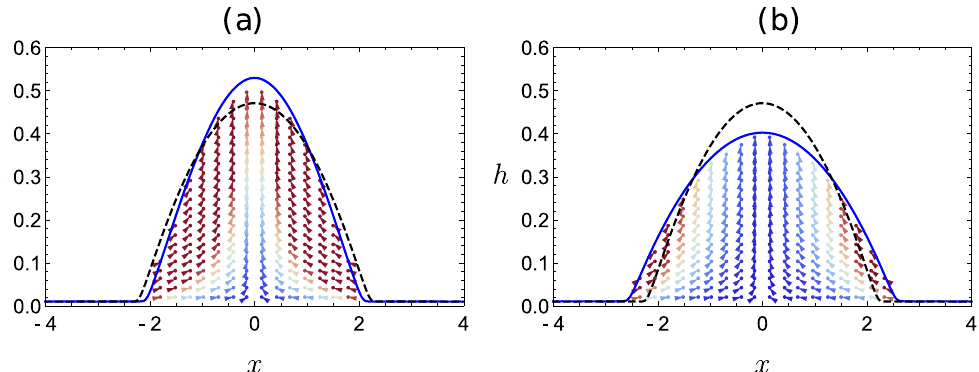
Fig. 6 Internal fl ow pro fi le. The velocity fi eld inside the sessile droplet under AC fi eld at t = 39.25 T p . a ε = 2, σ = 20, and b ε = 10, σ = 2. The remaining parameters are Ω = π /50 and O c = 10. The equilibrium shape of the droplet without an electric fi eld (dashed curve) is used as the initial condition.